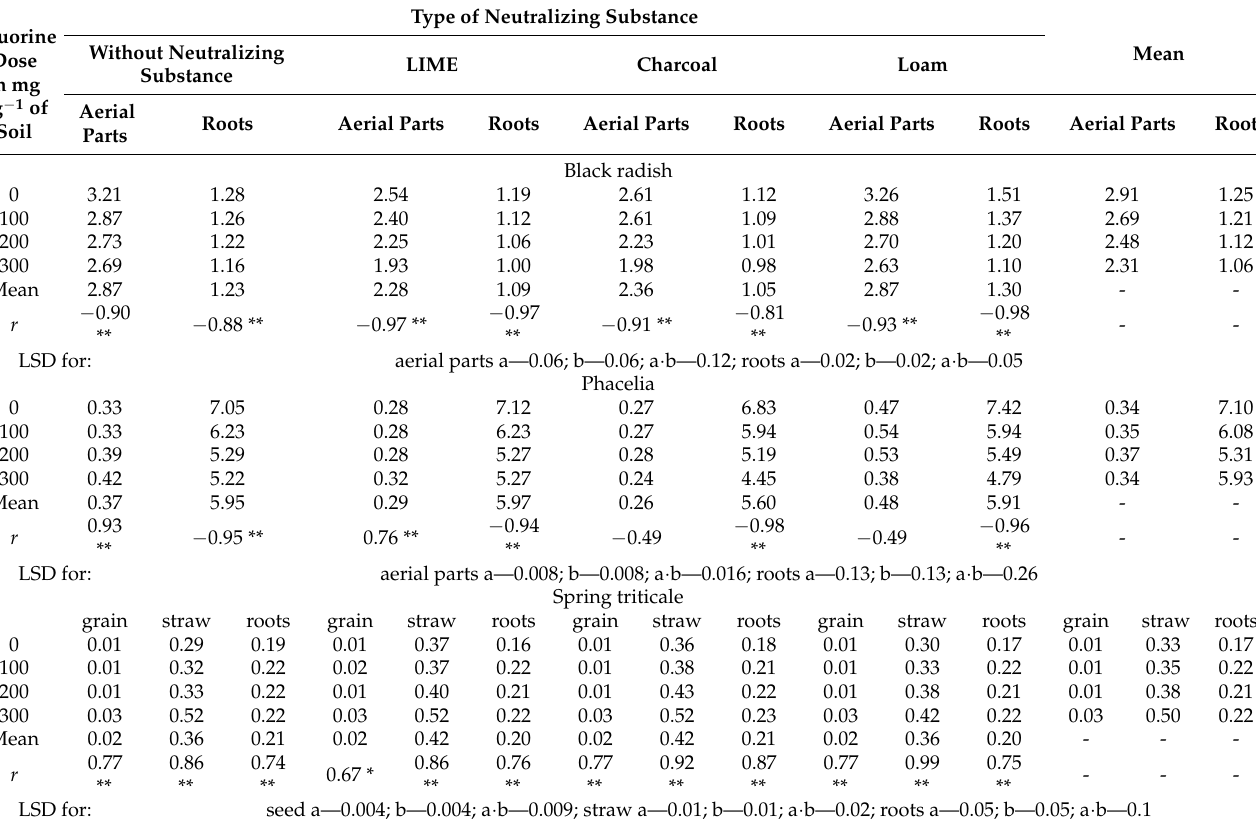
Table 3. Sodium content in black radish, phacelia, and spring triticale in g Na kg − 1 DM.